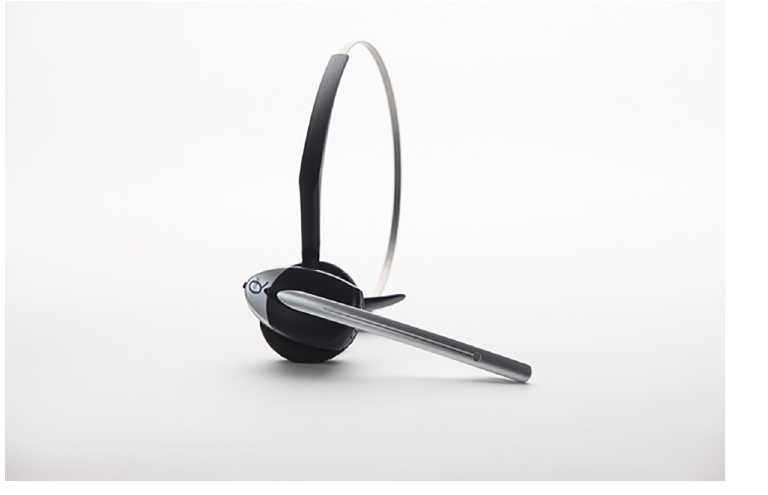
Fig 1. Quail digital wireless